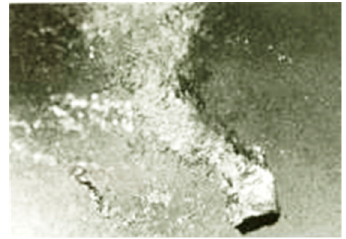
Figure 3. Typical aspect of vortex cavitation, which produces severe impact [63].